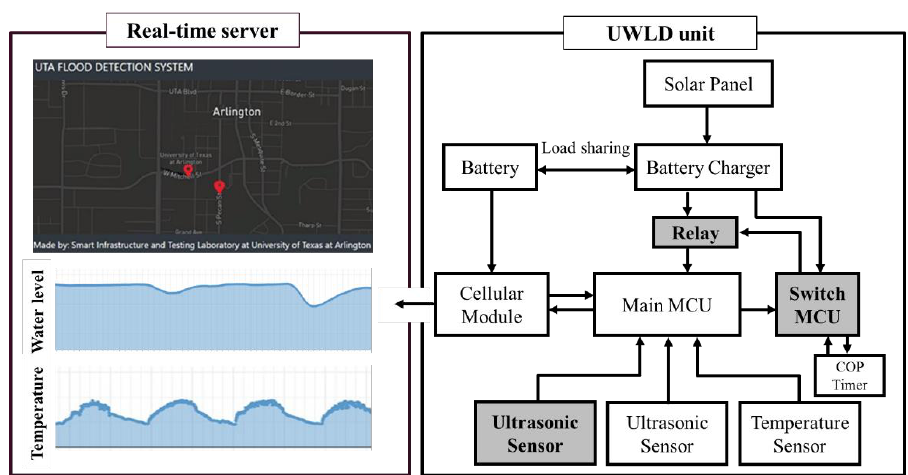
Figure 7. System representation of UWLD-3 system with dual-target sensing and dual MCUs.